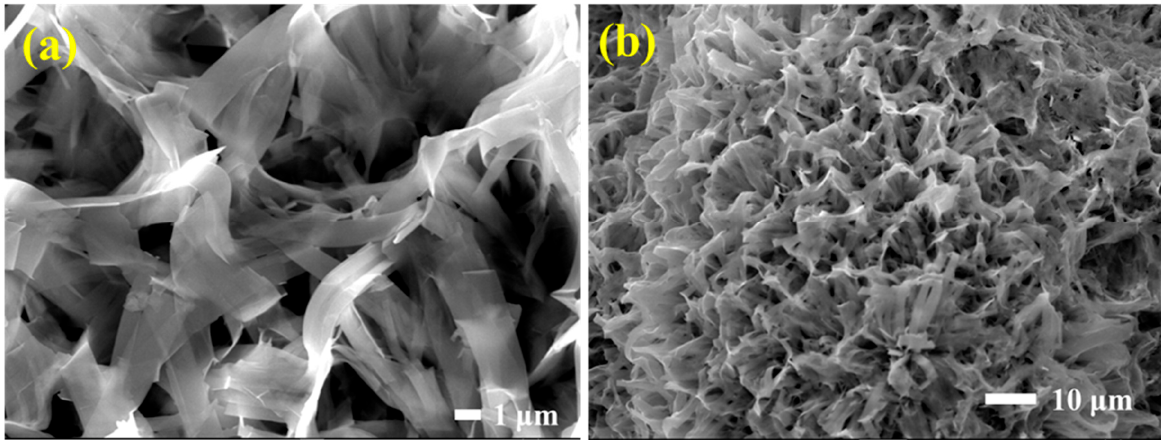
Figure 3. SEM images of ( a ) Hydrothermally synthesized ZnO and ( b ) ZnO/PVDF composite.